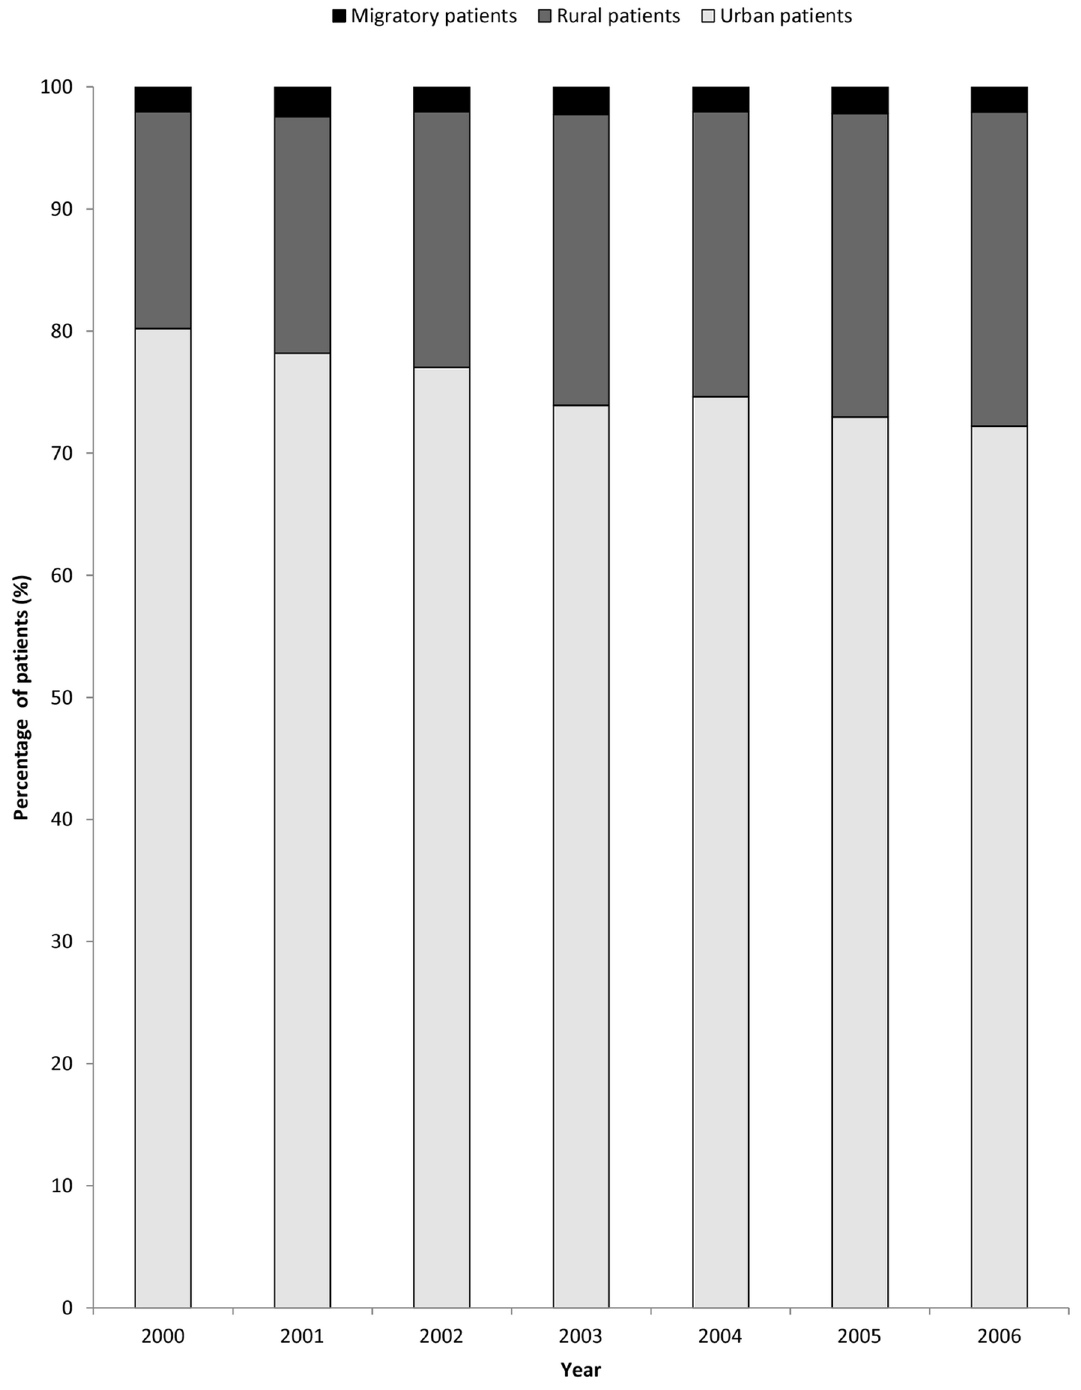
Figure 1. Urban-rural disparities of cancer patients with first-time hospice care from 2000–2006.